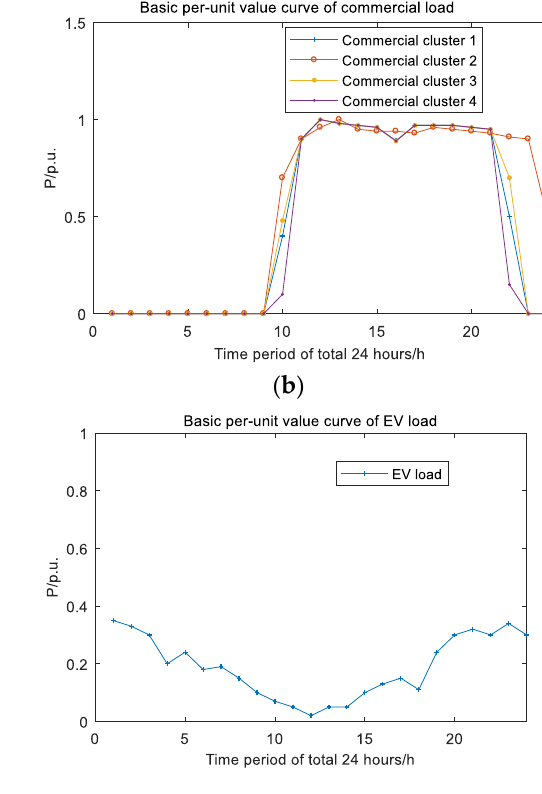
Figure 12. The basic per-unit value curve of output prediction. ( a ) Wind power; ( b ) PV power.